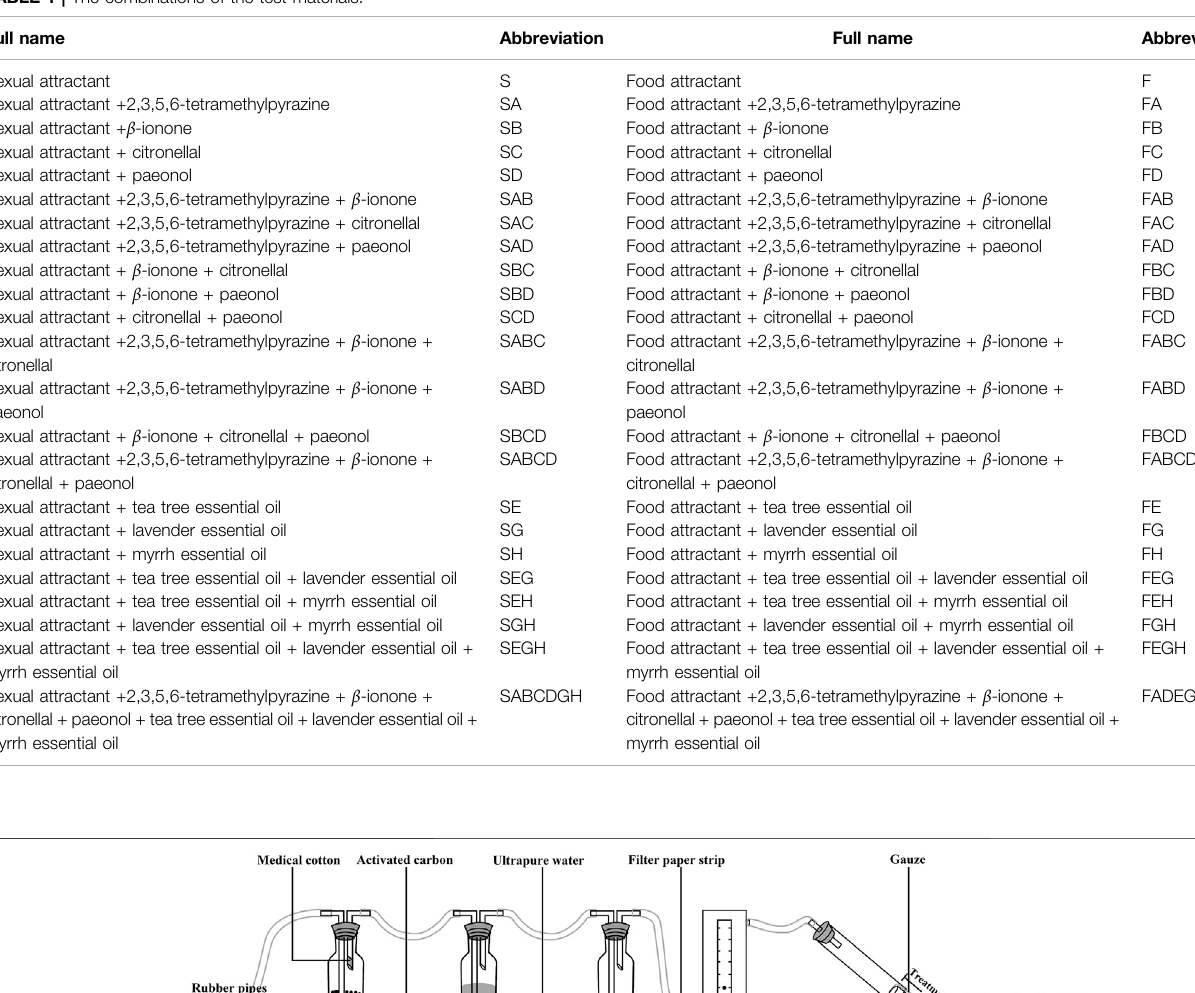
TABLE 1 | The combinations of the test materials.